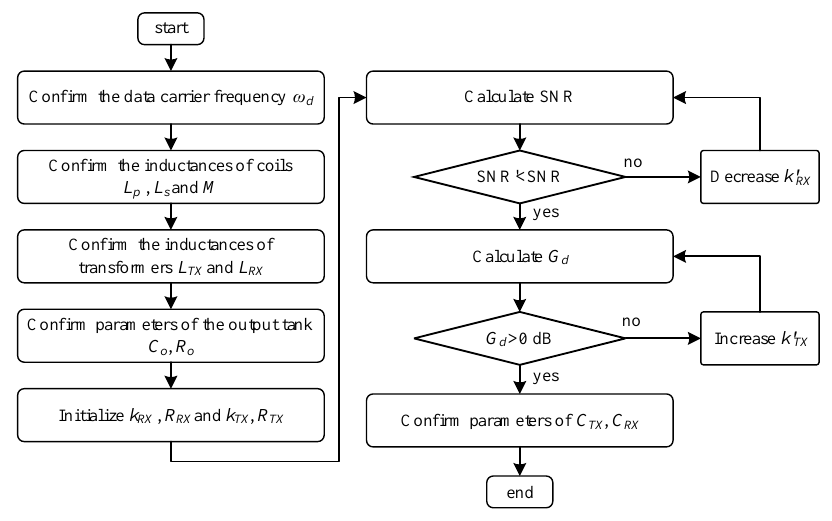
Figure 12. Flow chart of the design for data channel parameters.